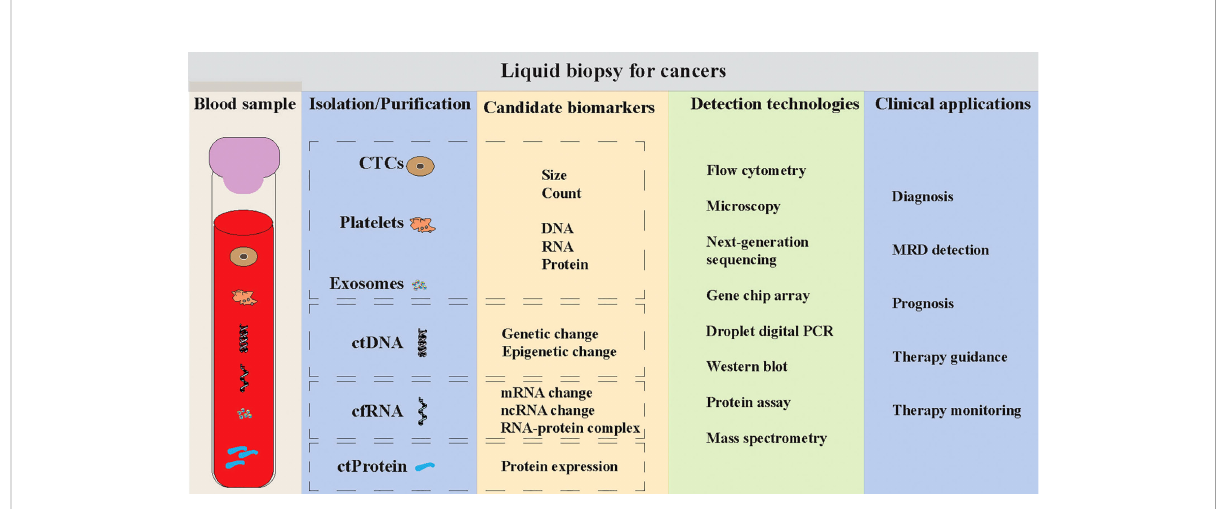
FIGURE 1 Liquid biopsy for human cancers. Liquid biopsy mainly consists of the detections of circulating tumor cells (CTCs), platelets, exosomes, circulating tumor DNA (ctDNA), circulating cell-free RNA (cf-RNA) and circulating tumor-associated protein (ctProtein). Multiple technologies can be applied to detect the tumor cell-associated information within these sources, such as morphological characteristics, DNA mutations, RNA expression, protein expression and epigenetic changes. The clinical applications of these liquid biopsy tools can be used for early cancer detection, minimal/measurable residual disease (MRD) detection, and monitoring the prognosis, therapy guidance and therapy monitoring of cancer